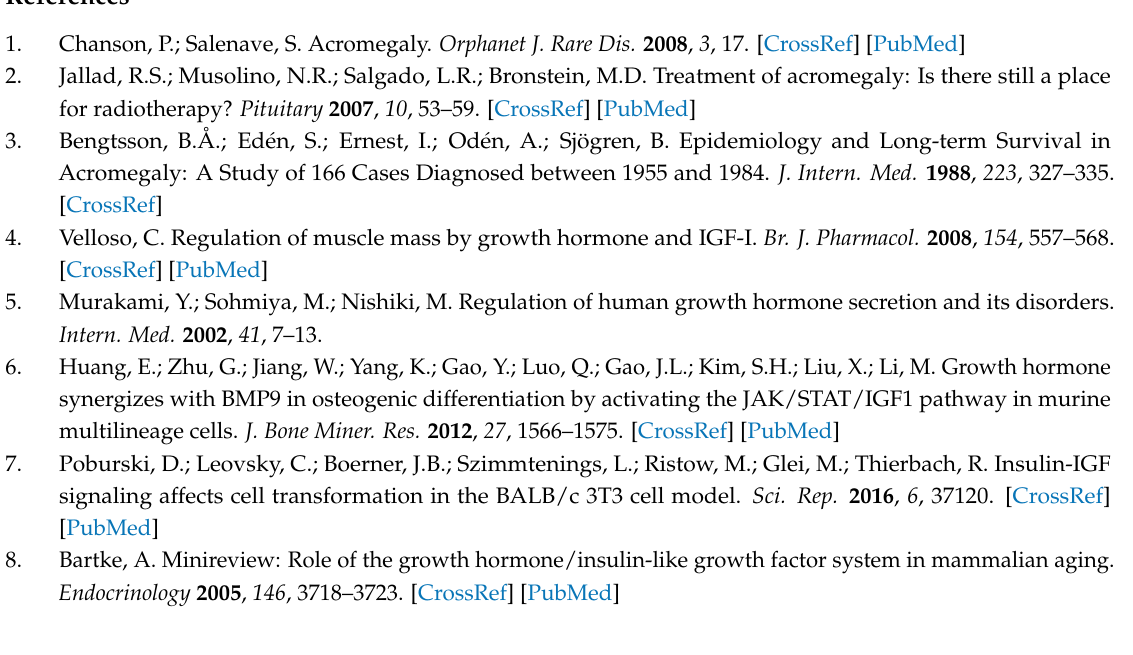
Table S1: Primers used for PCR, Table S2: Sequences of qPCR primers for selected genes, Table S3: DNA damage gene set used for